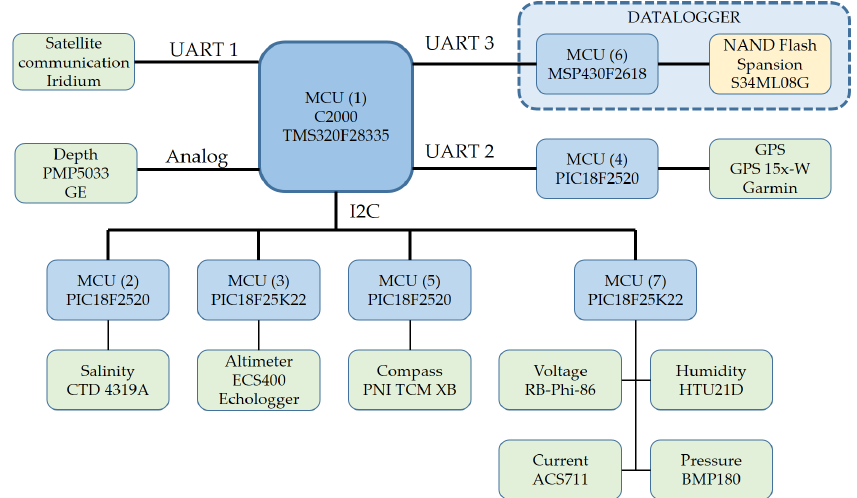
Figure 3. Central controller and datalogger connection diagram. The central controller takes the data from the sensors and sends it to the datalogger. The datalogger is completely dedicated to storage.